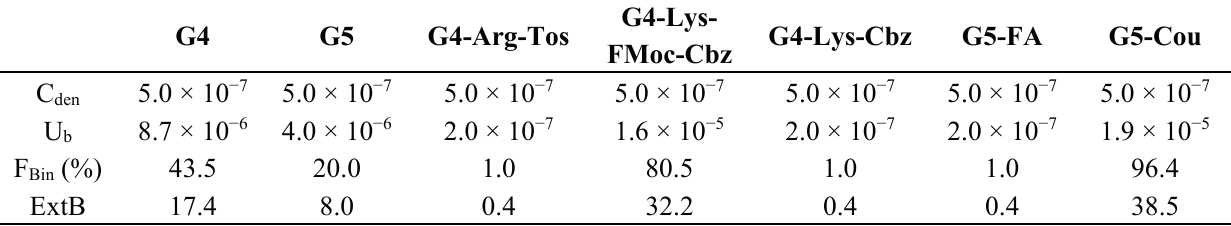
Figure 2. Fractional binding of the different dendrimers synthesized for U(VI). Table 3. Affinity of synthesized PAMAM dendrimers by